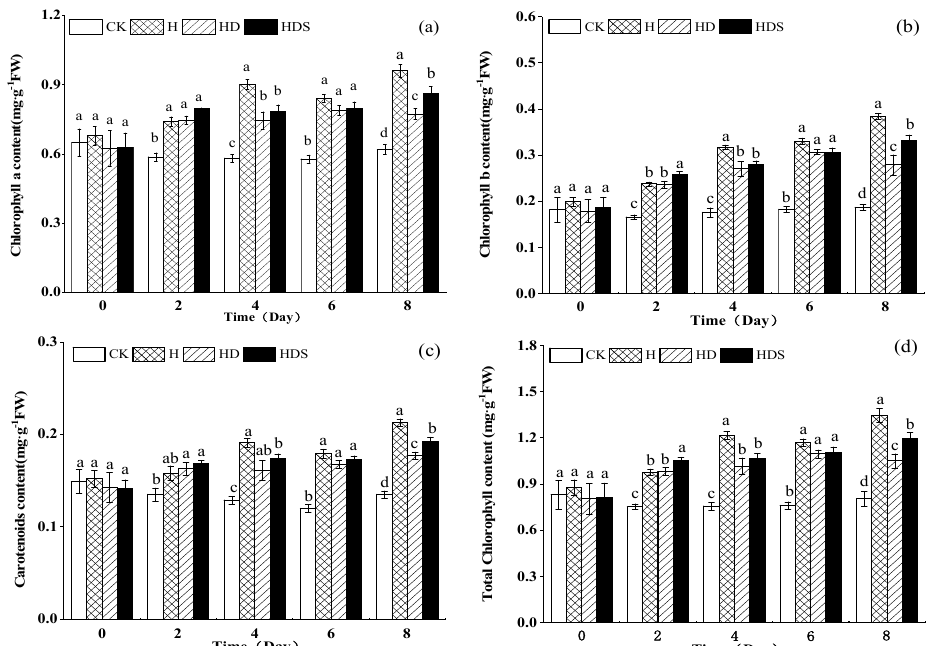
Figure 2. Effects of exogenous spermidine and D - arg on the Chla ( a ), Chlb ( b ), Car ( c ), and total Chl ( d ) content of lettuce under high-temperature stress. Vertical bars represent standard deviations of the mean ( n = 3). Values above each vertical bar followed by different letters show significant differences ( p < 0.05). CK, 22 ° C /17 ° C , deionized water; H, 35 ° C /30 ° C , deionized water; HD, 35 ° C /30 ° C , 1 mM D - arg; HDS, 1 mM D - arg+ 1 mM Spd.